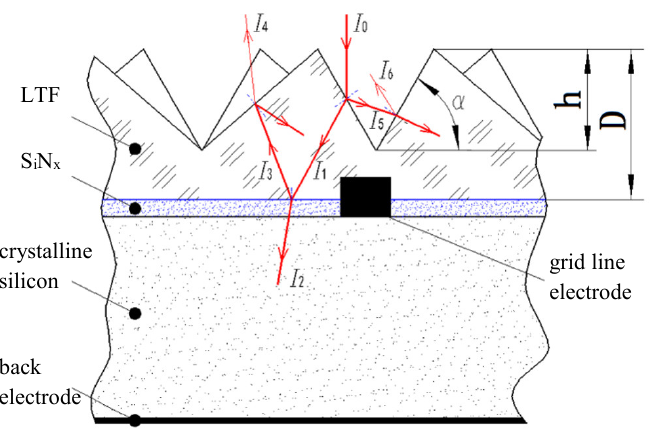
Figure 1. Composite laminate structure.